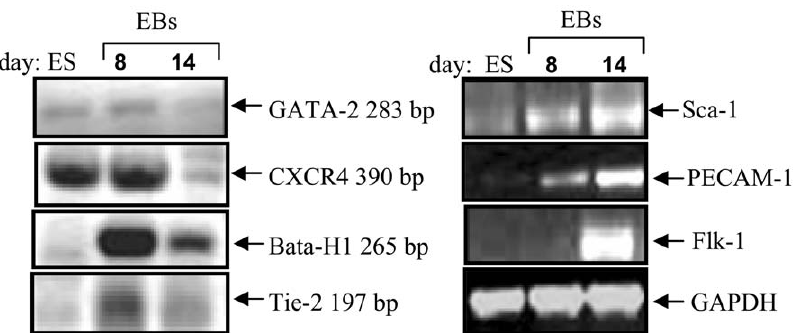
Figure 2. Time course of hematopoietic differentiation of mES-E14/GFP. Differentiated hematopoietic EBs at days 8 and 14 were analyzed by RT-PCR analysis. This is a representative experiment out of 5.